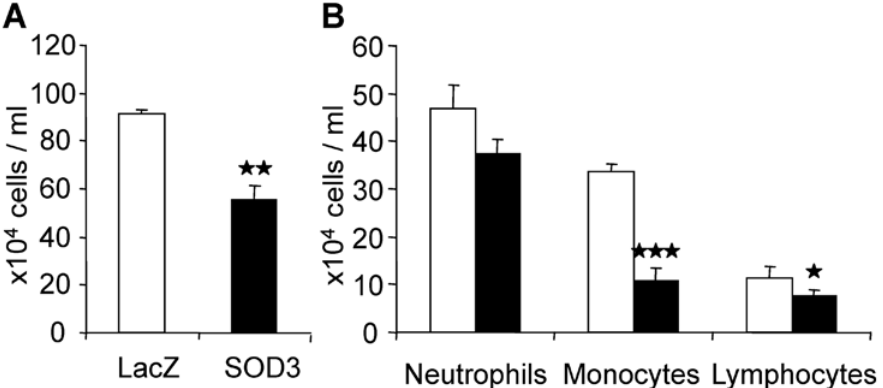
Figure 3. Anti-inflammatory effect of SOD3 affects predominantly macrophages in peritonitis model. Open bars represent LacZ animals and black bars represent SOD3 animals. (a) SOD3-mediated reduction in total leukocyte number in peritoneal lavage 18 hours after induction of inflammation. SOD3 treated animals had 55.6 6 10 4 ( 6 4.1) cells/milliliters of lavage as compared to 91.6 6 10 4 ( 6 6.7) found from LacZ control animals. (b) Analysis of different leukocyte subtypes showed strongest effect in macrophages although lymphocyte migration was also reduced. Monocyte accumulation in LacZ vs. SOD3 treatment was reduced from 33.5 6 10 4 ( 6 1.8) to 10.9 6 10 4 ( 6 2.5) cells/ml whereas lymphocytes were reduced from 11.4 6 10 4 ( 6 2.2) to 7.6 6 10 4 ( 6 1.2) cells/ml, and neutrophils from 47.0 6 10 4 ( 6 4.7) to 37.5 6 10 4 ( 6 2.9) cells/ml.